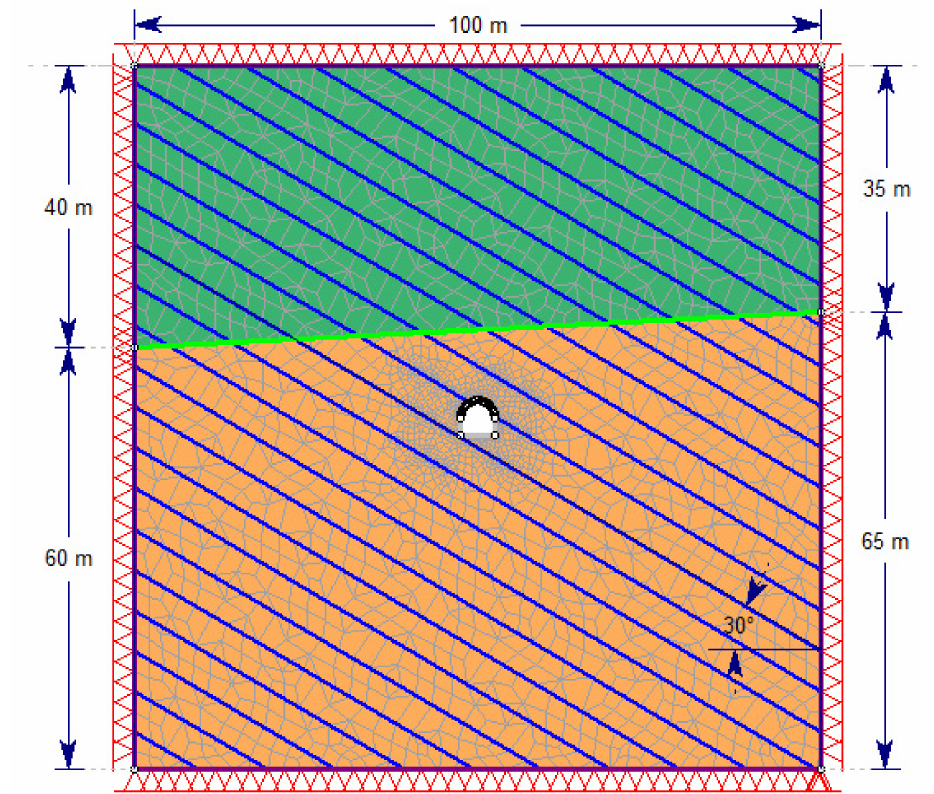
Figure 2. Geometry, dimensions and boundary conditions of the reference tunnel model